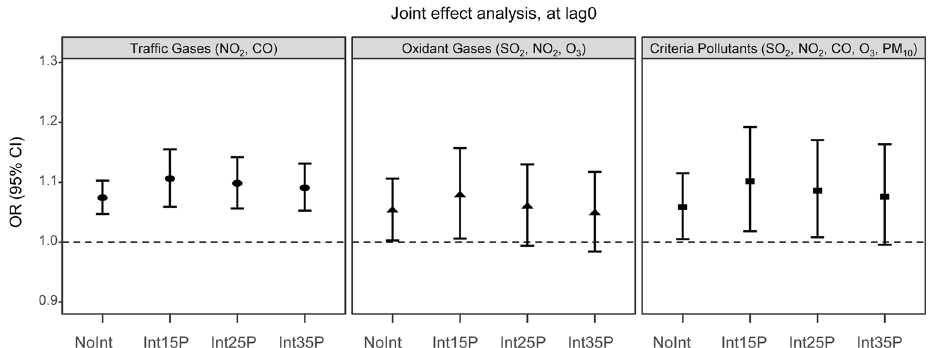
Figure 3. Joint effect of specific pollutant combinations for Meniere’s disease. Joint effect estimates of odd ratios (ORs) and 95% CIs for Meniere’s disease hospital visits considering interquartile range (IQR) increase in concentrations of specific pollutant combinations on the case or control day (lag0) are presented using conditional logistic model including multiple pollutants with and without interactions. In the interaction models, the joint effects for the concentration change corresponding to the IQR were calculated, starting at the 15th, 25th, and 35th percentile level of each pollutant. This figure was drawn using R: a Language and Environment for Statistical Computing (version 3.3.3; R Core Team, Vienna, Austria, https:// www.R- proje ct. org). NoInt: No interactions; Int15P: interaction, starting at 15th percentile; Int25P: interaction, starting at 25th percentile; Int35P: interaction, starting at 35th